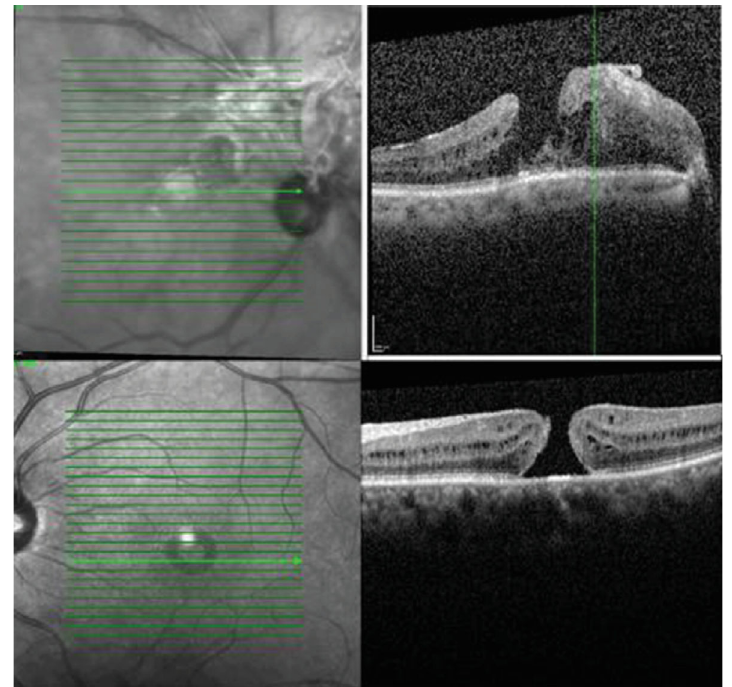
Figure 1: Macular OCT. Thick ERM on optic nerve head extending to the fovea causing lamellar macular hole and intra-retinal edema (OD). Full thickness macular hole (Figure 1). Fluorescein angiography (FA) revealed peripheral vasculitis in both eyes in addition to a peripheral avascular area and temporal neovascularization in the left eye (Figure 2).